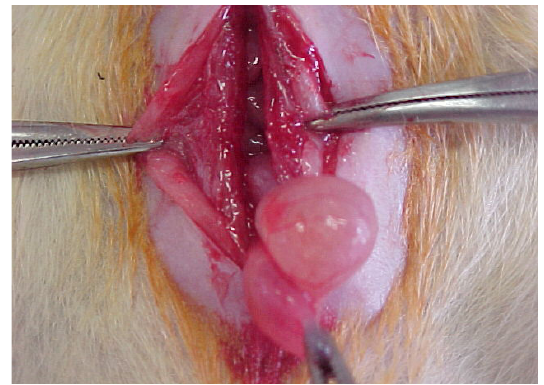
FIGURA 1 - Árvore da Jatropha gossypiifolia L . No local da coleta da amostra